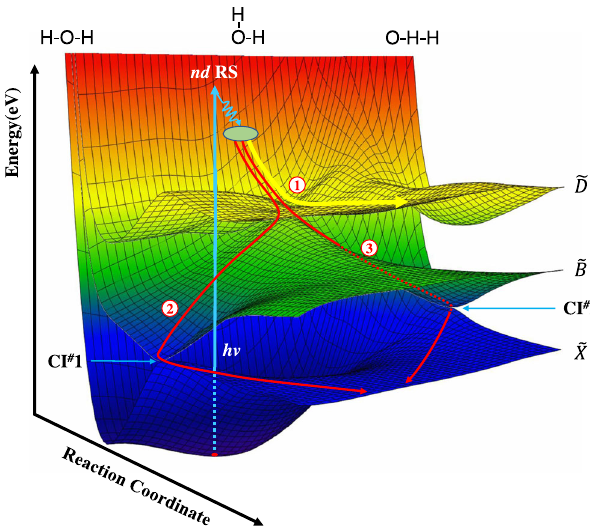
Fig. 3 Illustration of the TBD mechanisms of H 2 O upon VUV excitation. Photoexcitation populates the nd Rydberg state ( nd RS) which undergo ef fi cient non-adiabatic coupling to the e D state. The light blue arrow displays the photoexcitation process and the gray oval represents the crossing region between the nd RS and the e D state. Path 1 illustrates the possible direct dissociation route from the e D state to form O( 1 D) + 2H products (the yellow curve). Paths 2 and 3 illustrate plausible routes for the more complicated O( 3 P) + 2H dissociation paths: from the e D state to the e B state and then to the ground state via the two conical intersections (CI #1 or CI #2), following the initial internal conversion from the excited nd RS to the e D state (the red curves). This picture is consistent with the observed angular anisotropy for the two channels: the O( 1 D) + 2H channel is a more direct dissociation process with larger angular anisotropy, while the O( 3 P) + 2H channel is a more complicated dissociation process with smaller angular anisotropy. The PES contour color from blue to red represents the potential energy from 0 to 12